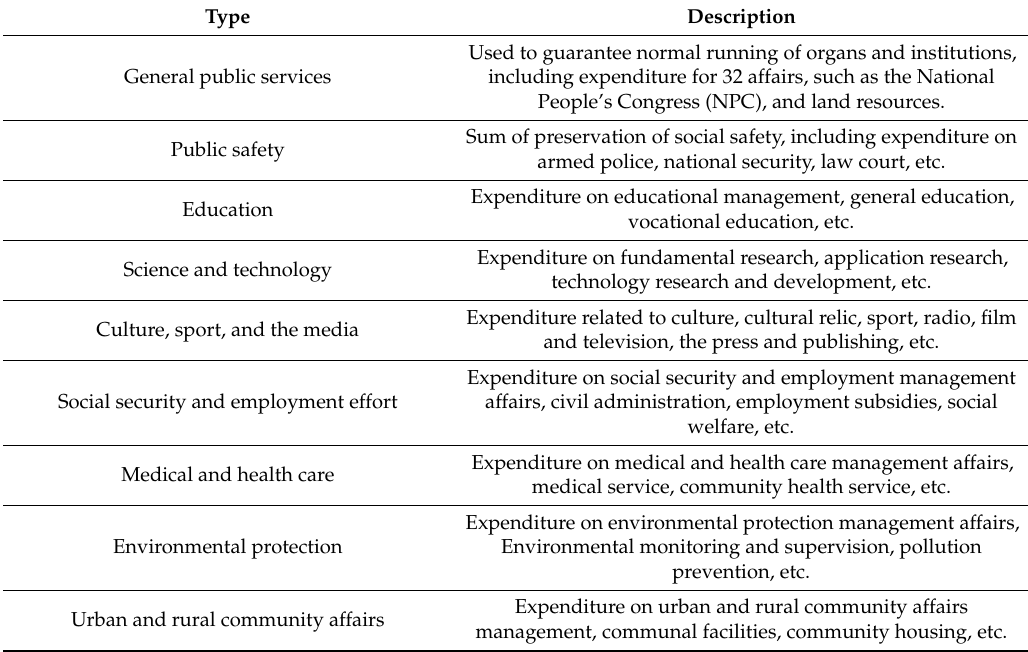
Table 2. Description of urban public services